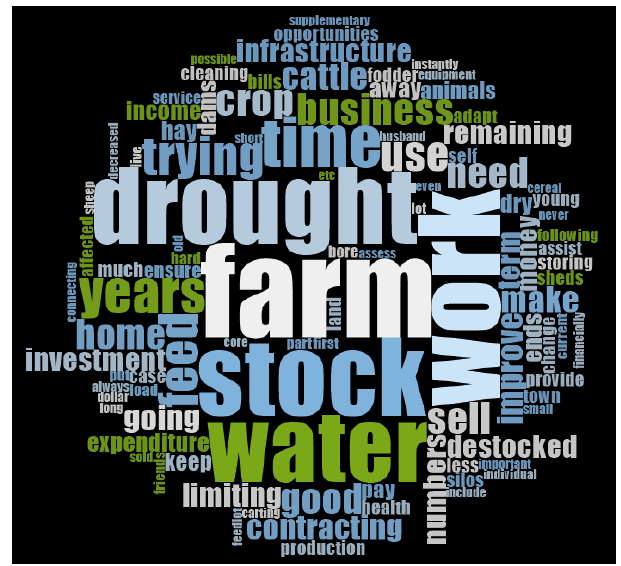
Figure 4. Word cloud showing the most common words used by participants in free-text responses when asked about the methods they were currently using to adapt to drought.